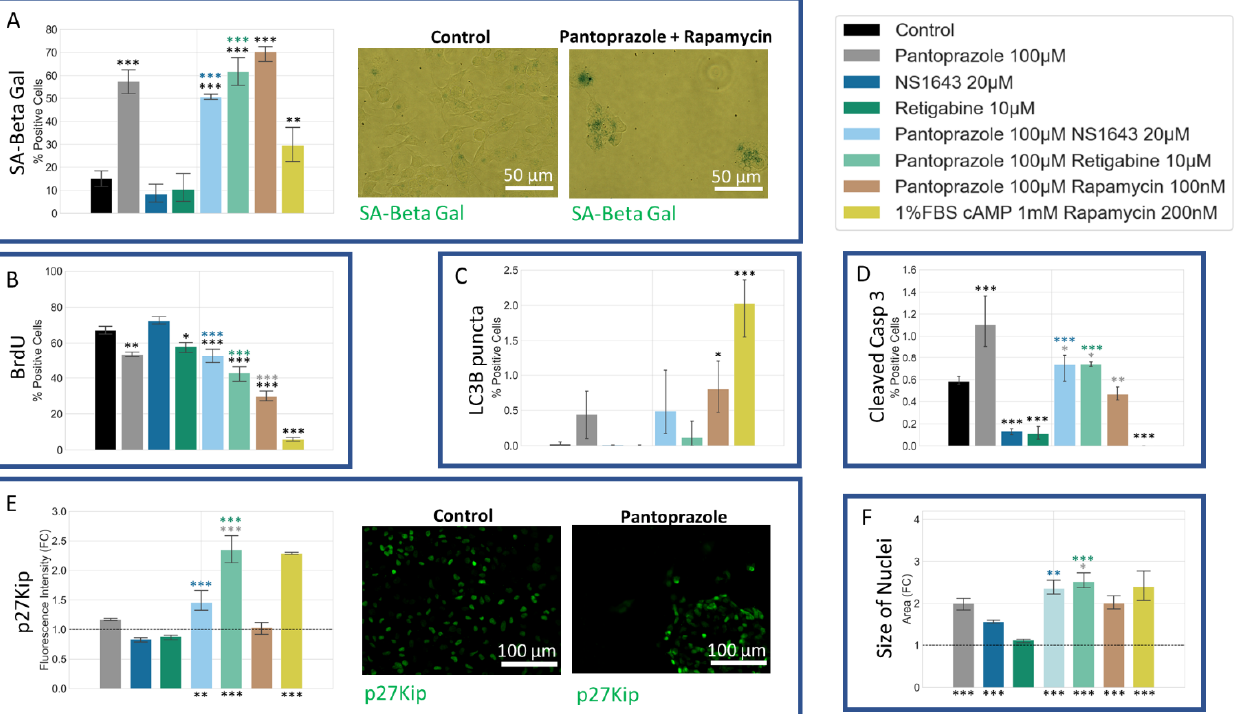
Figure 10. Senescence and Proliferation Analysis of NG108-15 Cells Reveals that Treatments with Pantoprazole Increased Senescence, Decreased BrdU Incorporation, and Increased a p27 Kip1 after 6 days. A senescence associated beta-galactosidase stain was conducted and scored by eye. Immunofluorescence of cells was conducted and analyzed with CellProfiler for integrated fluorescence intensity or presence or absence of a cellular signal. ( A ) Stain of senescence associated beta-galactosidase stain (SA-Beta Gal). ( B ) Stain of bromodeoxyuridine incorporation (BrdU). ( C ) Stain of the microtubule-associated protein light chain 3 B (LC3B). ( D ) Stain of cleaved caspase 3 (Casp 3). ( E ) Stain of cyclin-dependent kinase inhibitor 1B (p27Kip). ( F ) Size of Nuclei, determined by area of the Hoechst stain. Treatments corresponding to the colored bars are outlined in the figure itself. The log of the fold change in intensity was compared between single treatments and combined treatments, except the positive control, with significant values shown in the color of the treatment compared. The initial fluorescence intensities were compared to their corresponding control, with significant values shown under the bars. The logit of the percent positive cells was compared between single treatments and control, in cases of 0 values, the arcsine transformation was used. Significance was expressed as, ***: p < 0.001, **: p < 0.01, * : p < 0.05 (one-way ANOVA with Tukey post hoc analysis n > 3 technical